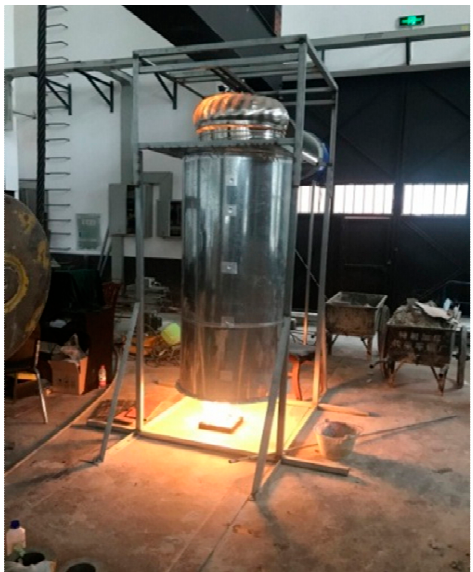
Figure 13. Photo of fire experiment.